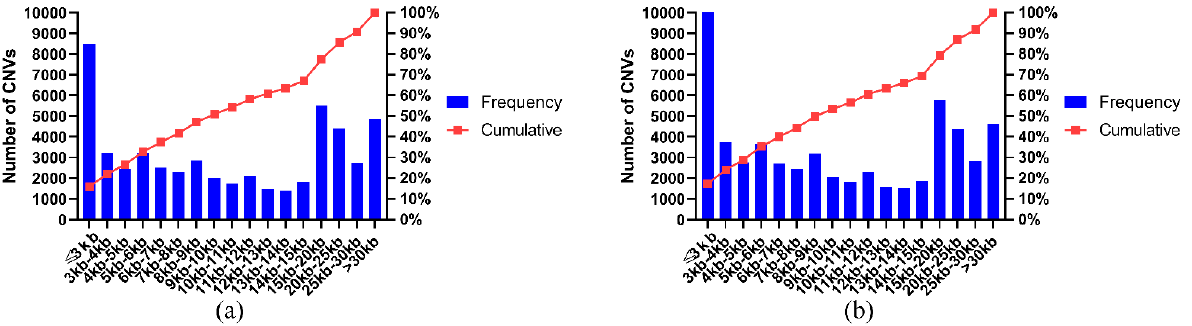
Figure 2. ( a ) CNV-size interval distribution of LTWY. Average CNV size is 13.9 kb and median size is 9.9 kb; ( b ) CNV-size interval distribution of NTWY, Average CNV size is 13.2 kb and median size is 9.3 kb. Table 2. Summary of CNV testing. Table 2. Summary of CNV